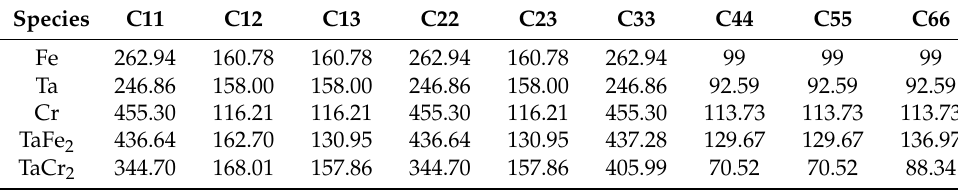
Table 8. Calculated elastic constants.